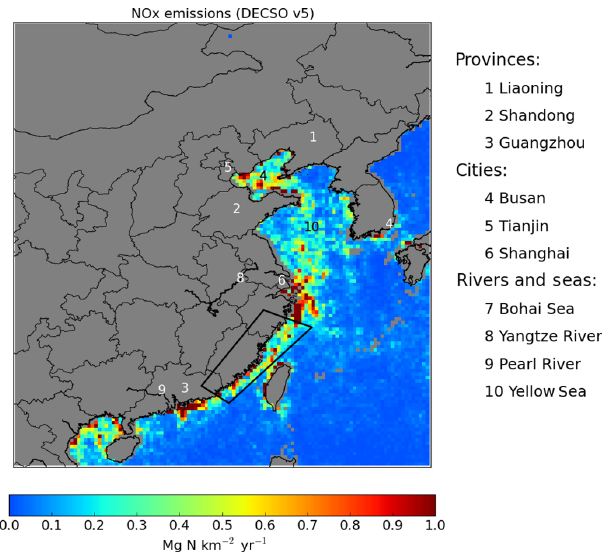
Figure 7. Emission estimates derived with DECSO v5 over the ocean in 2013. The black quadrangle indicates the selected area for analysing shipping emissions in the Taiwan Strait. Figure 8. Ship locations at 5 November 2015 from Automatic Identification System (AIS) information (taken from http://www.